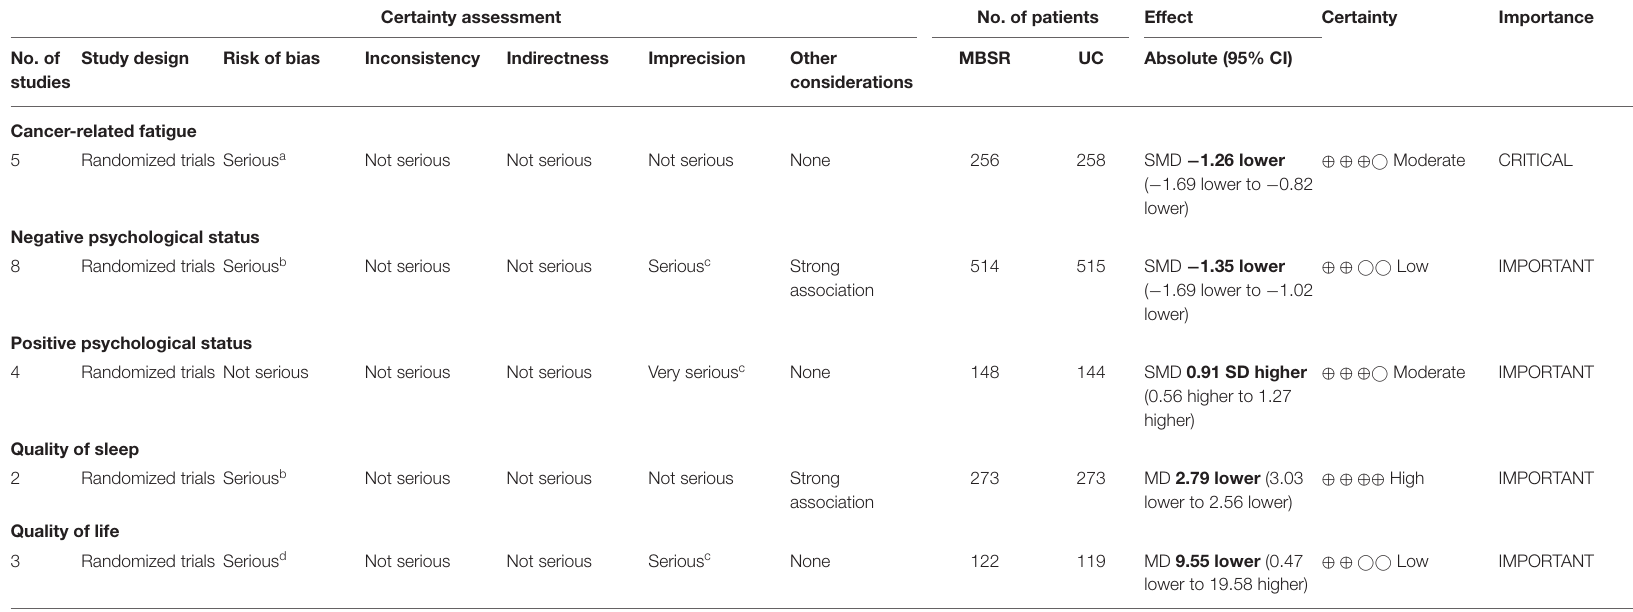
TABLE 2 | The level of evidence based on the Grading of Recommendations Assessment, Development and Evaluation (GRADE) system. Certainty